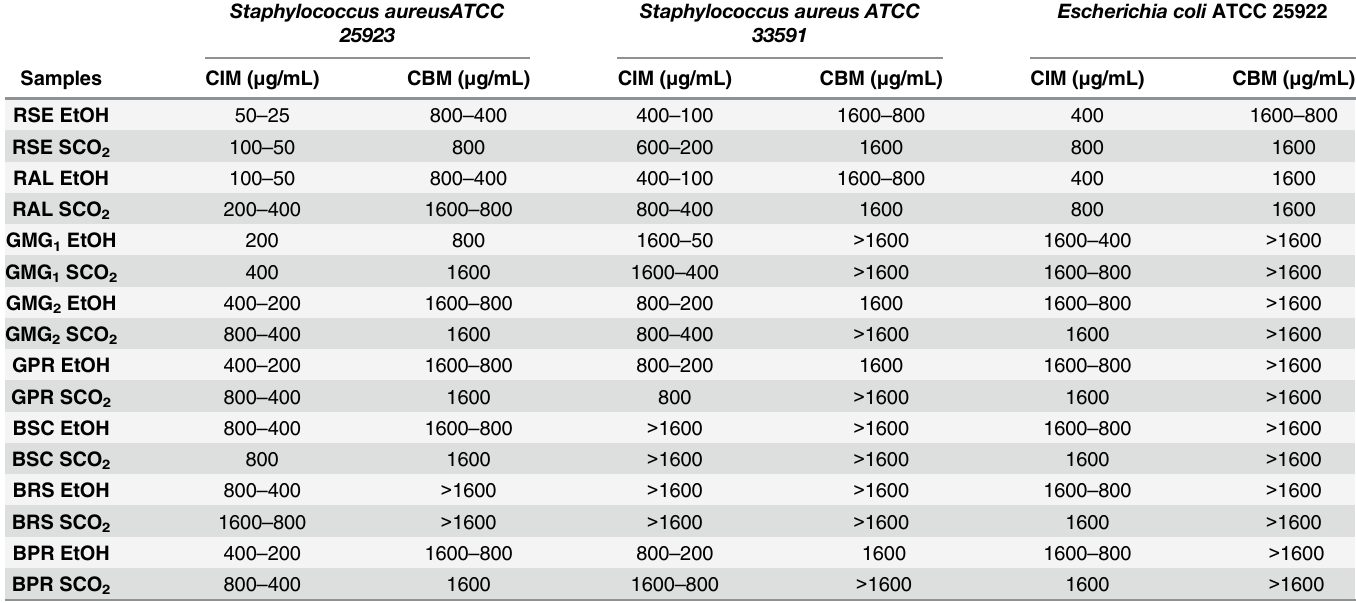
Table 6. Determination of Minimal Inhibitory Concentration (MIC) and Minimal Bactericide Concentration (MBC) of the extracts from different sam- ples of Brazilian propolis obtained by ethanolic extraction (EtOH) and by SFE (SCO 2 ). Staphylococcus aureusATCC 25923